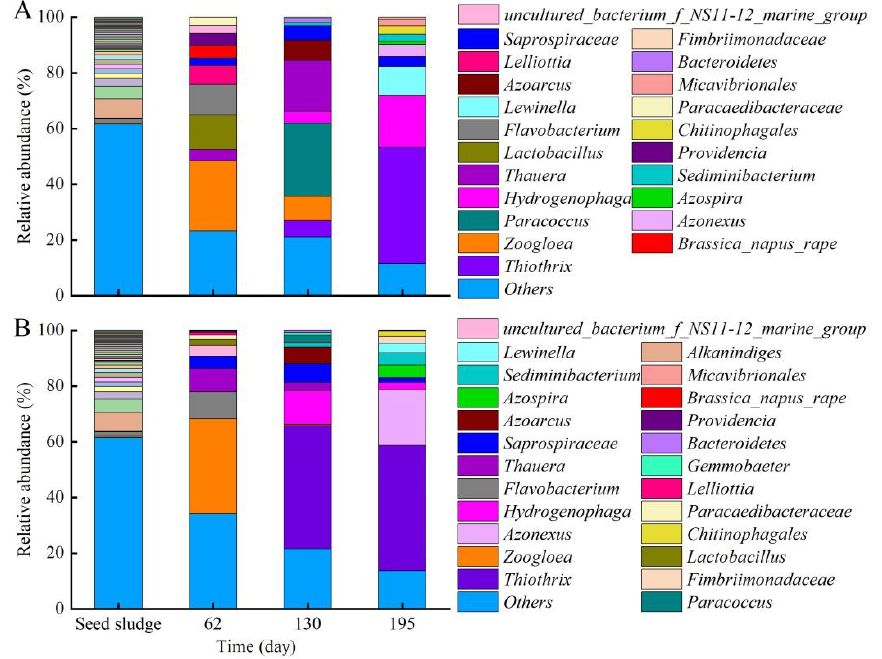
Figure 10. Microbial community structure and distribution at genus level in R1 and R2 during the long-term operation period. ( A ) for R1; ( B ) for R2.